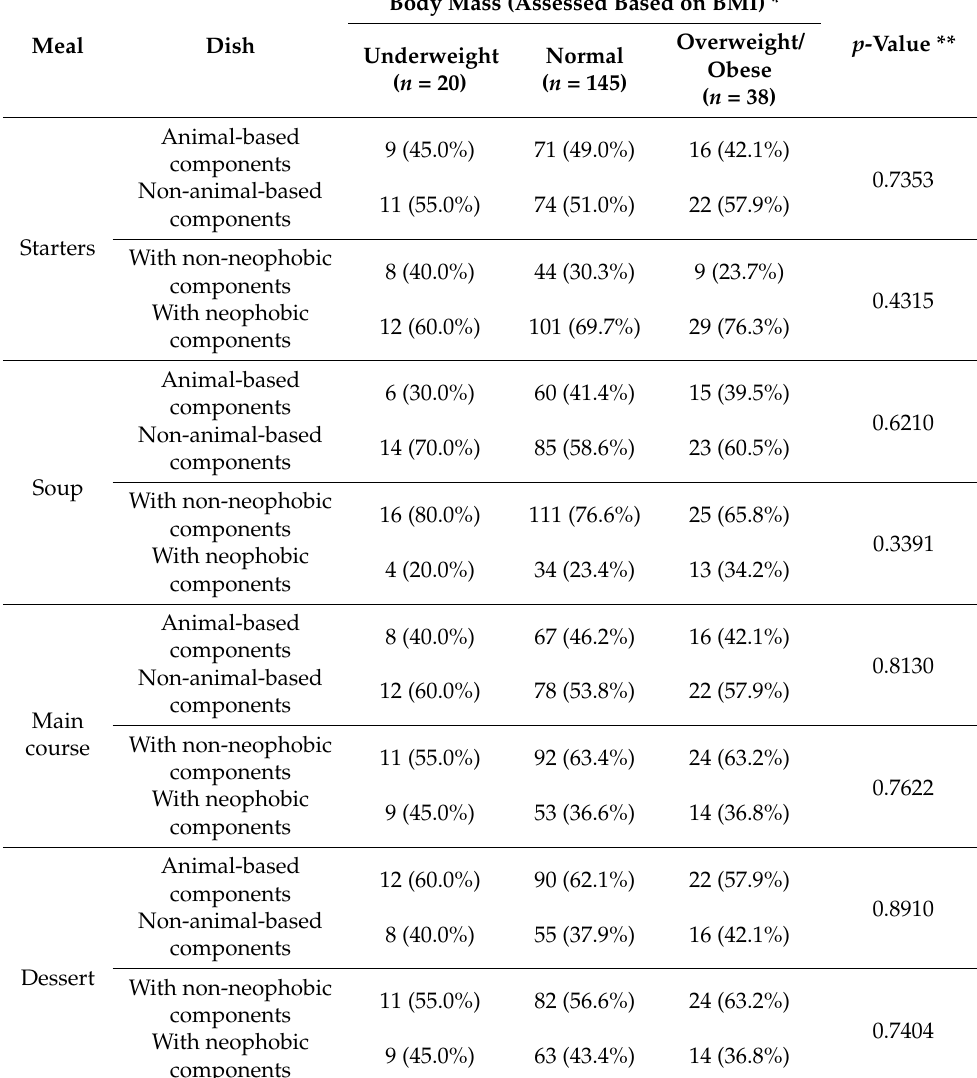
Table 11. The dish choices made by the studied sample of young Polish women from the model French restaurant menu. The dishes are organized within sub-groups of those containing animal- based components/non-animal-based components, or those with non-neophobic components/with neophobic